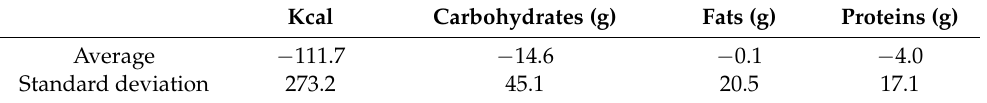
Table 1. Differences between generated APP levels and those obtained from